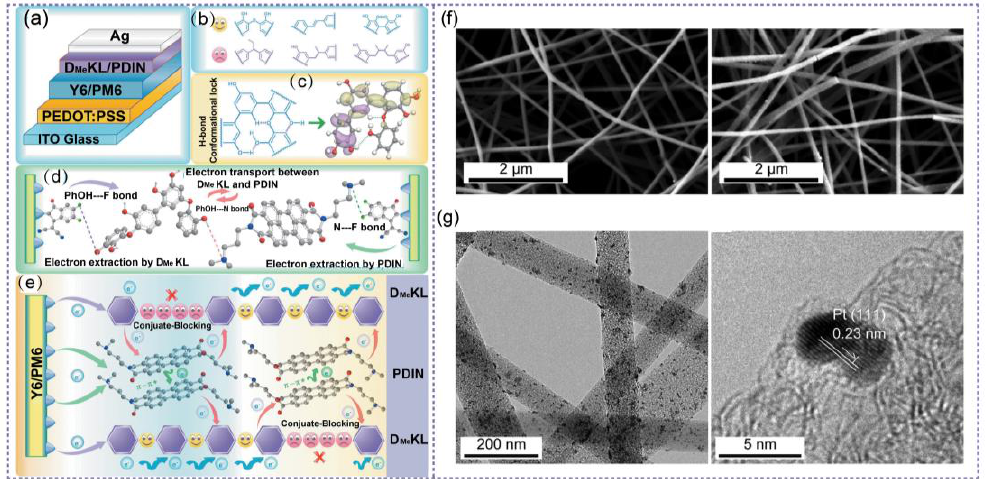
Figure 8. ( a ) Device structure. ( b ) Typical linkages of conjugate and conjugate-blocked in D Me KL. ( c ) Intramolecular conformational locks formed in D Me KL by hydrogen bonds. ( d ) Secondary bonds assist in the extraction and transport of electrons. ( e ) Preparation of electron transfer 3D network by D Me KL/PDIN/Y6. ( f ) SEM images showing typical shapes of ECNFs and ECNFs – Pt nano-felts. ( g ) TEM images of ECNFs – Pt nano-felts (From Refs. [106,107]).